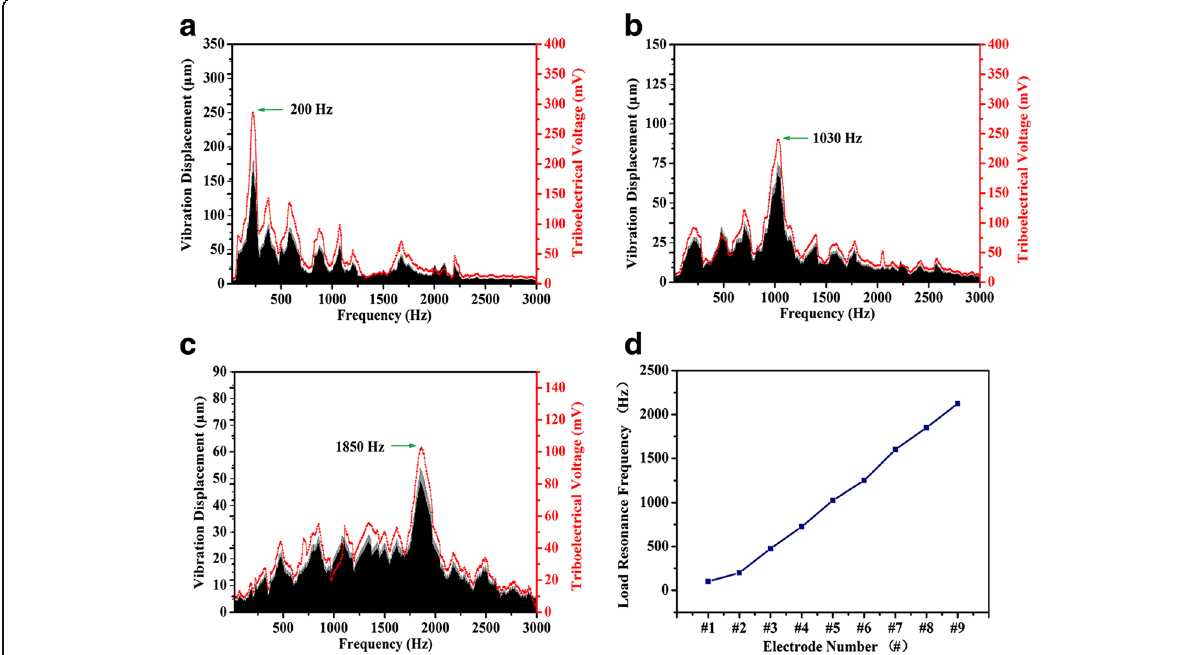
Fig. 4 Research result of the triboelectric voltage output signal and the vibration amplitude from a electrode #2, b electrode #5, and c electrode #8, which was measured by LDV system and oscilloscope in the frequency ranging from 20 to 3000 Hz, and a distribution of the vibration displacement and the triboelectric voltage output signal were closely overlapped all over the frequency bandwidth. d Experimental results of the relationship between the electrode number and the local resonance frequency of the PTFE